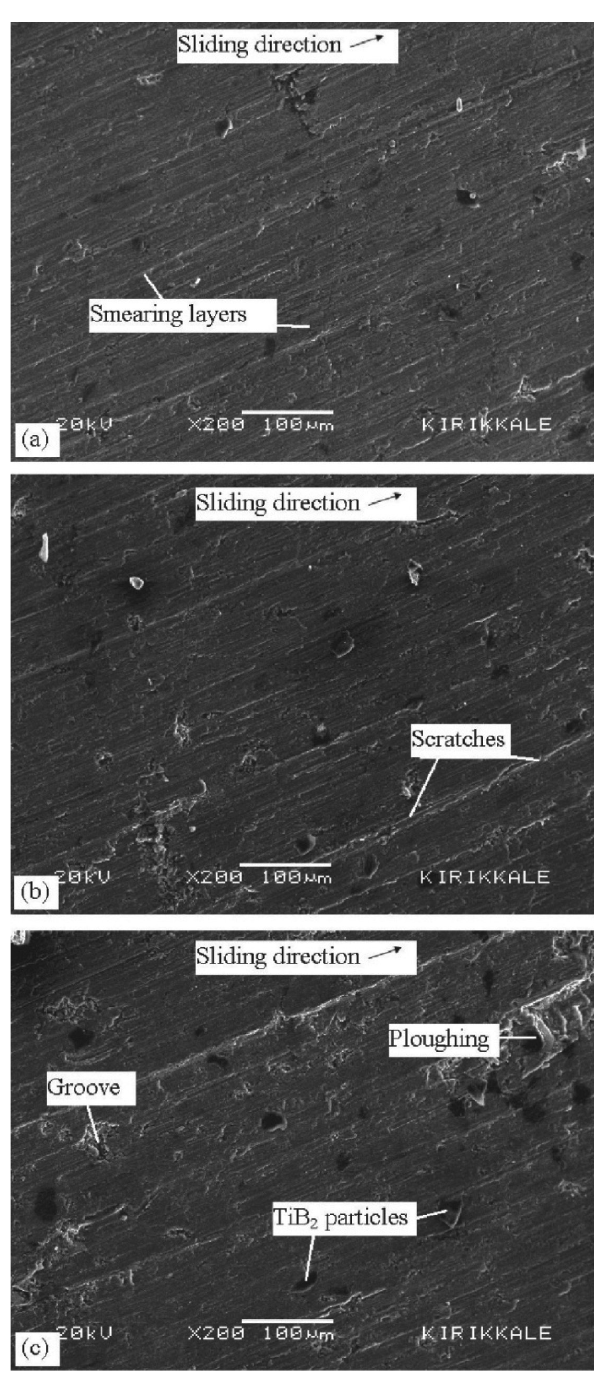
Fig. 9: SEM images of the worn surfaces of the Al 2014-8% TiB 2 composite tested at different loads, with a sliding speed of 0.5 m‧s −1 for a sliding distance of 40 m: (a) 10 N, (b) 30 N and (c) 50